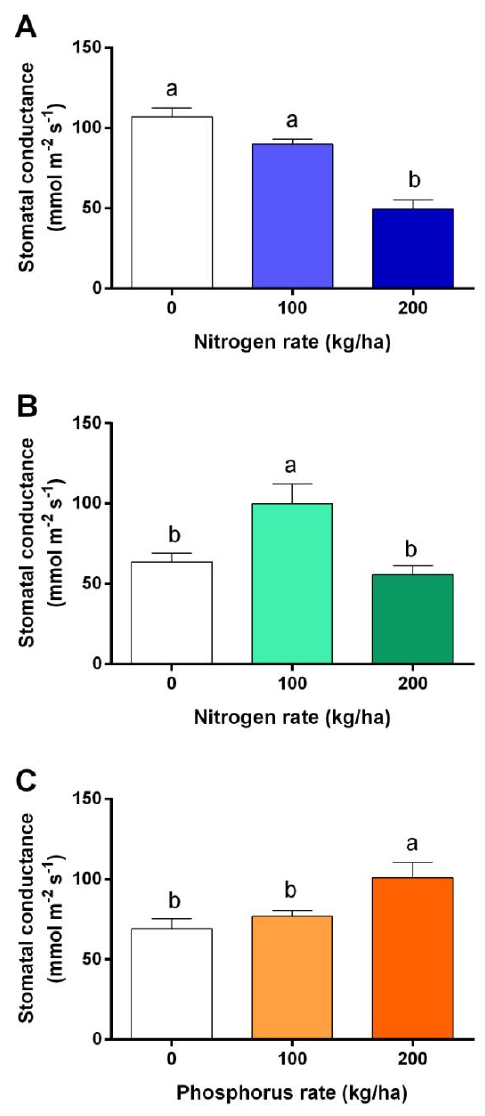
Figure 2. Effects of N application in early flowering ( A ) and late flowering ( B ) on foliar stomatal conductance and effect of P application on foliar stomatal conductance in early flowering ( C ). Different letters on the top of the bars indicate significant difference at p < 0.05 by Duncan.